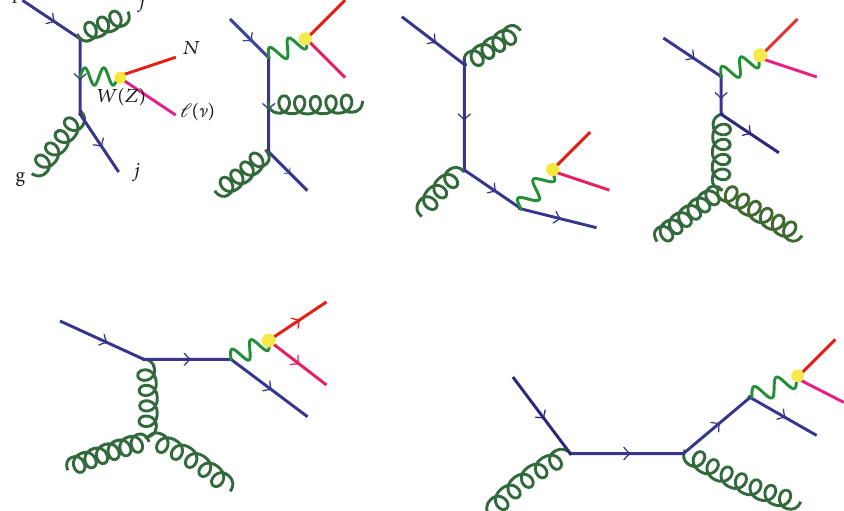
Figure 6: 2-jet process to produce 𝑁 with ℓ( ] ) in association with a jet from the CC(NC) interaction from qg initial state.